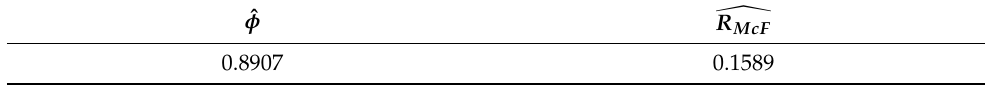
Table 6. Estimates of φ and R McF .